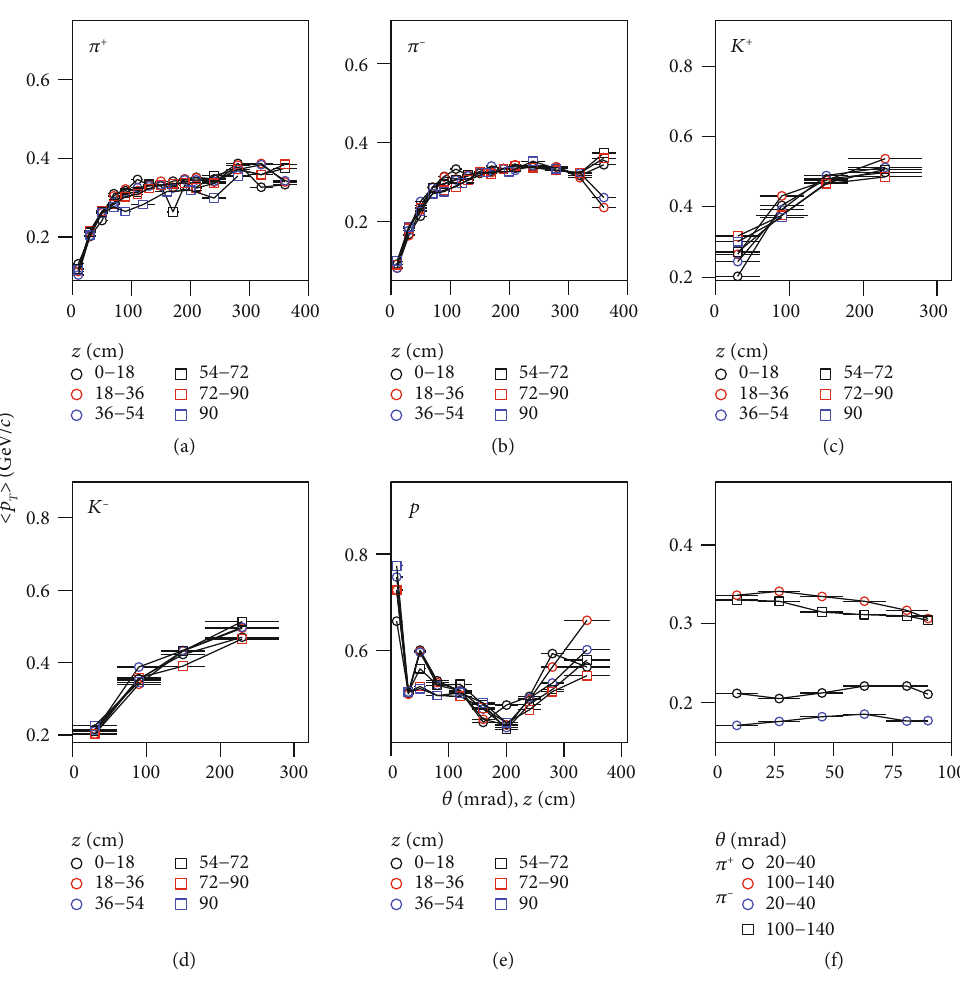
i on (a – e) θ , which are extracted from the data samples within di ff erent z ranges for π + , π − , K + , K − , and p , Figure 12: Dependence of h p T respectively, and on (f) z , which are extracted from the data samples within di ff erent θ ranges for π + and π −